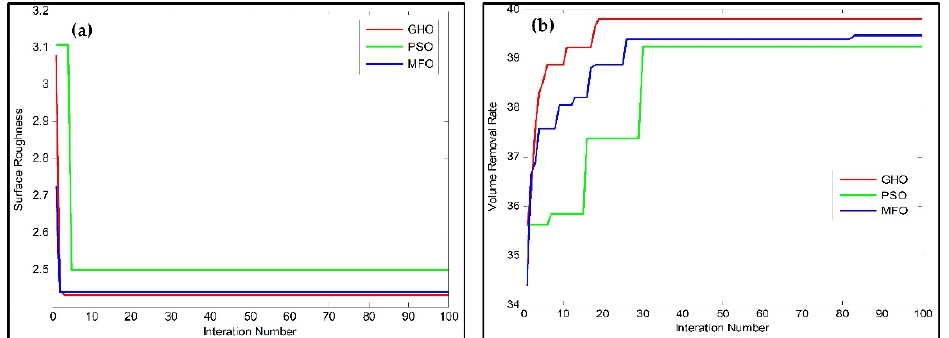
Figure 7. Convergence plot for ( a ) SR and ( b ) VRR. Table 12. Results of the confirmation